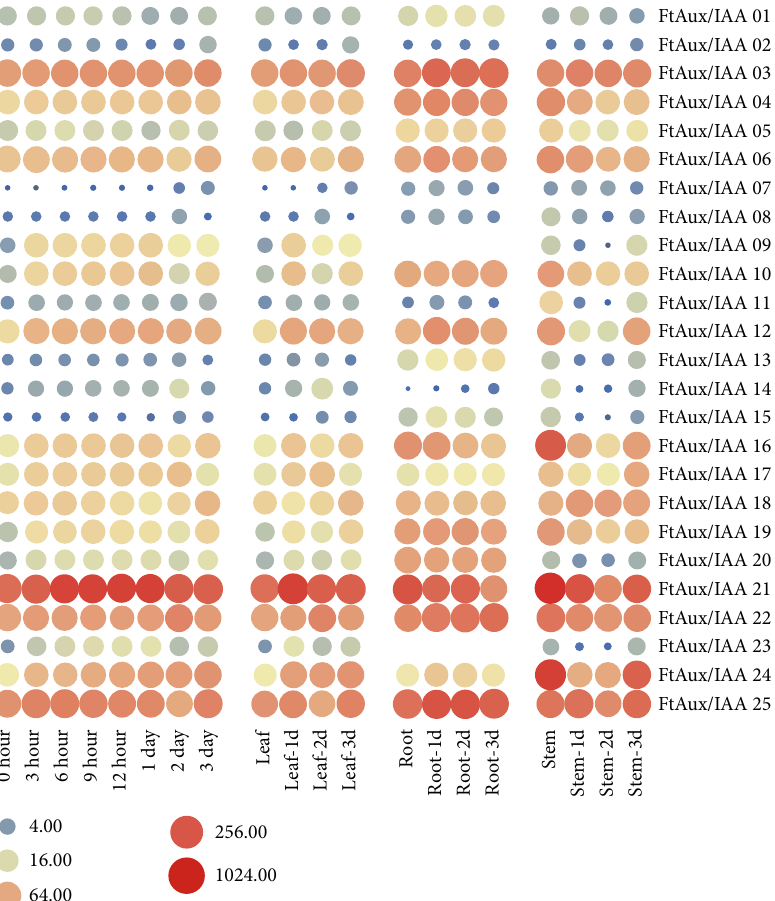
Figure 6: The pattern of transcript levels of 25 FtAux/IAA genes in buckwheat after IAA treatment compared with that of the control in di ff erent tissues. qRT-PCR was used to assess FtAux/IAA gene transcript levels in total RNA samples extracted from the leaves, stems, and roots after IAA treatment at the two-leaf